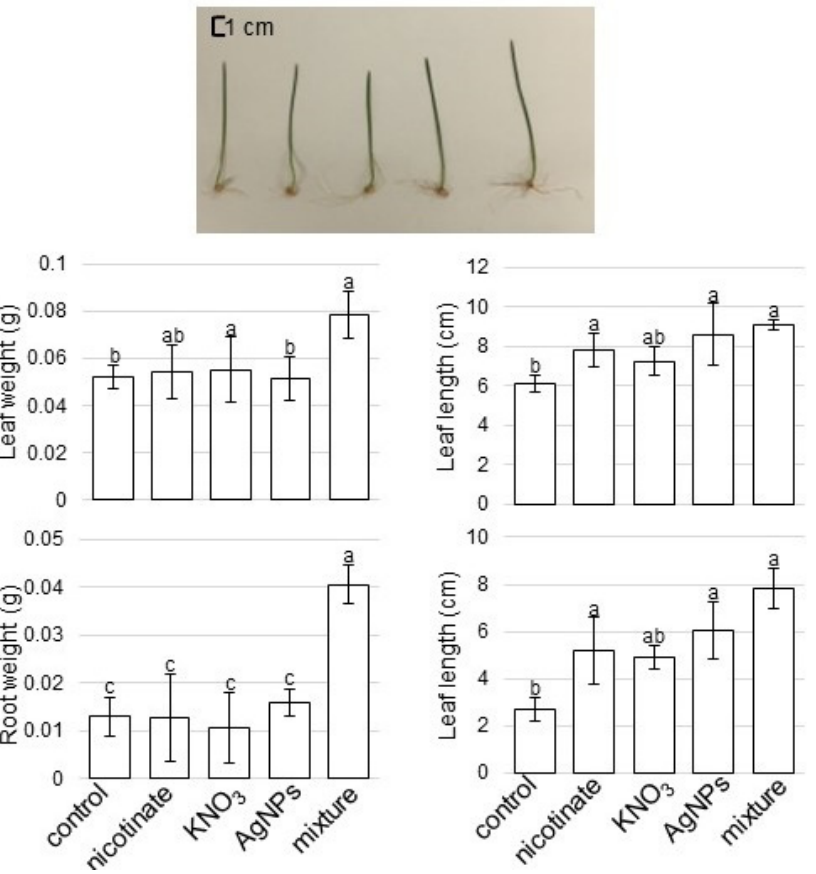
Figure 2. Morphological change of wheat treated with AgNPs, nicotinate, and KNO 3 . Three-day-old wheat seedlings were treated with and without 8 mM nicotinate, 0.1 mM KNO 3 , 5 ppm AgNPs, and 5 ppm AgNPs/8 mM nicotinate/0.1 mM KNO 3 (mixture) for 3 days. Leaf-fresh weight, leaf length, total root-fresh weight, and main-root length were measured. Scale bar in the picture shows 1 cm. The data are presented as mean ± SD from 3 independent biological replicates. Mean values of each point with different letters are significantly different according to one-way ANOVA followed by Tukey’s multiple comparison test ( p < 0.05).